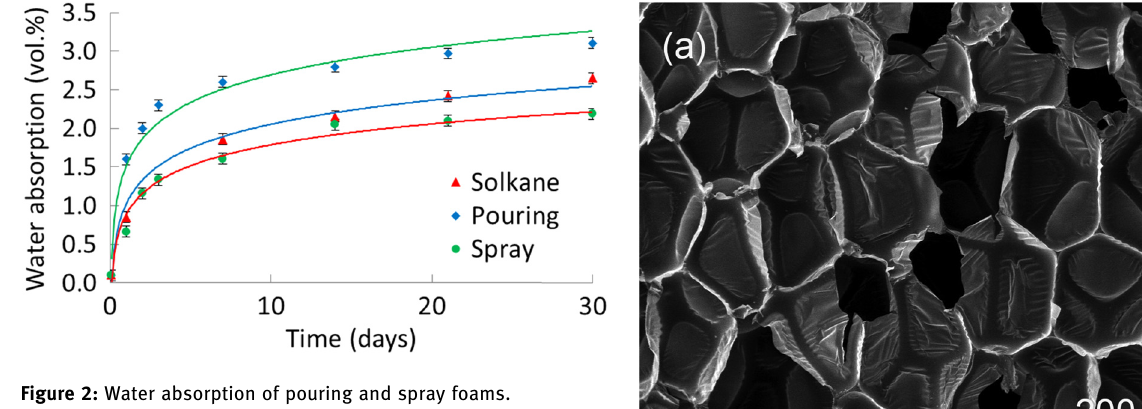
Figure 2: Water absorption of pouring and spray foams.